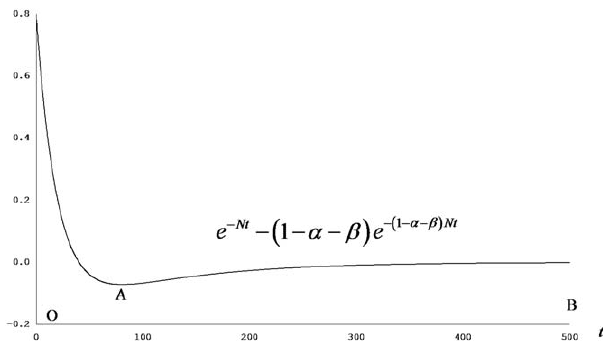
Figure 2. Capital growth premium: aid effect on capital formation. Equation (30) can be summarised as e { N (1 { a { b ) t { e { Nt (cid:6) (cid:7) , of which the term positive. Thus, the effect of foreign aid on the speed of capital growth is proportional to e { N (1 { a { b ) t { (1 { a { b ) e { Nt irrespective of the magni- tude of the coefficient present figure can also be derived by taking the time derivative of the curve shown in Figure 1. The situation is same for (showing the negative effect of the same absolute value) for The diagram shows a sample case where N =0.05 and a + b =0.8.